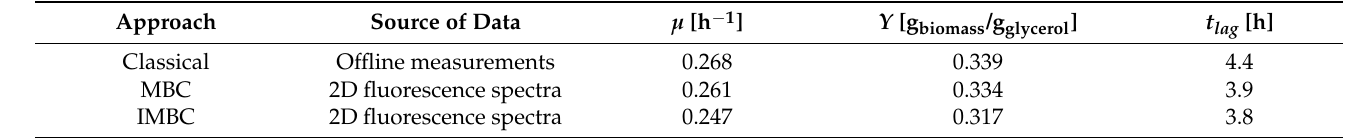
Table 2. Optimized process model parameters obtained in different approaches.